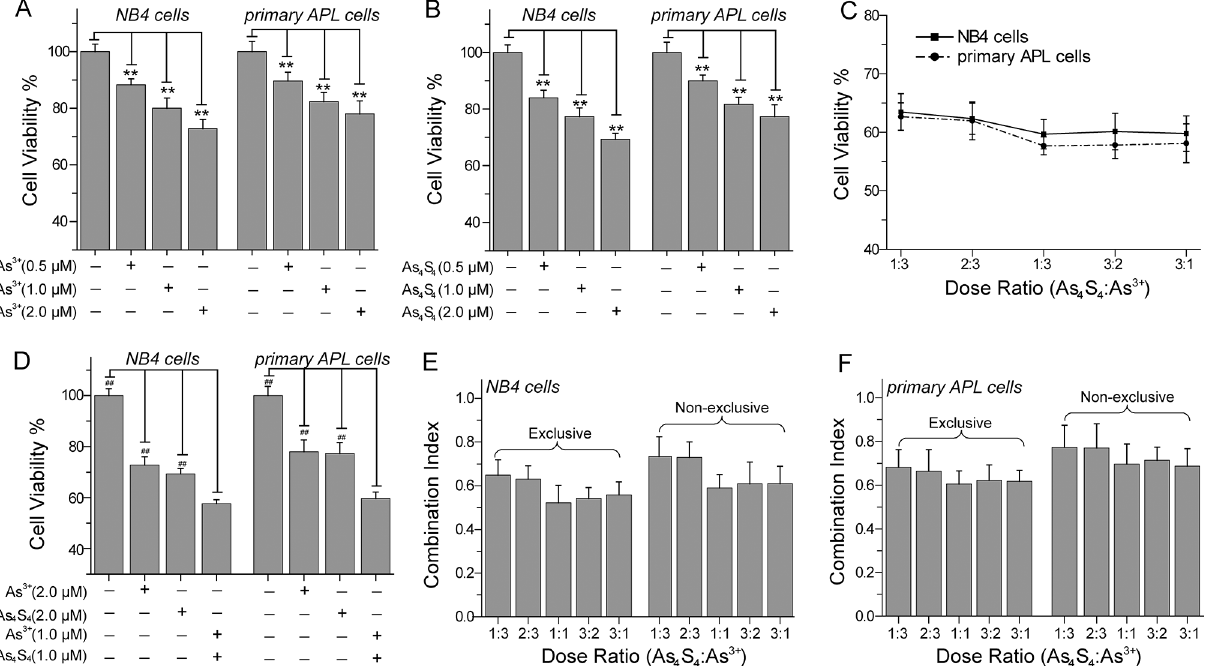
Fig 1. The effects of combining As 3+ and As 4 S 4 on the growth of NB4 and primary APL cells. (A) The effects of As 3+ on cell viability. (B) The effects of As 4 S 4 on cell viability. (C&D) The combined effects of As 3+ and As 4 S 4 on cell viability. (E) CI of concurrent treatment with As 3+ and As 4 S 4 in NB4 cells. (F) CI in primary APL cells. CI < 1.0 indicated a synergistic effect. The viability of NB4 and primary APL cells were determined by WST-1 cell proliferation assay kit after 48 h of treatment. Error bars represent the S.D. from the mean of three separate experiments. ** P < 0.01 compared with the control. ## P < 0.01 compared with As 3+ and As 4 S 4 combination treated cells.